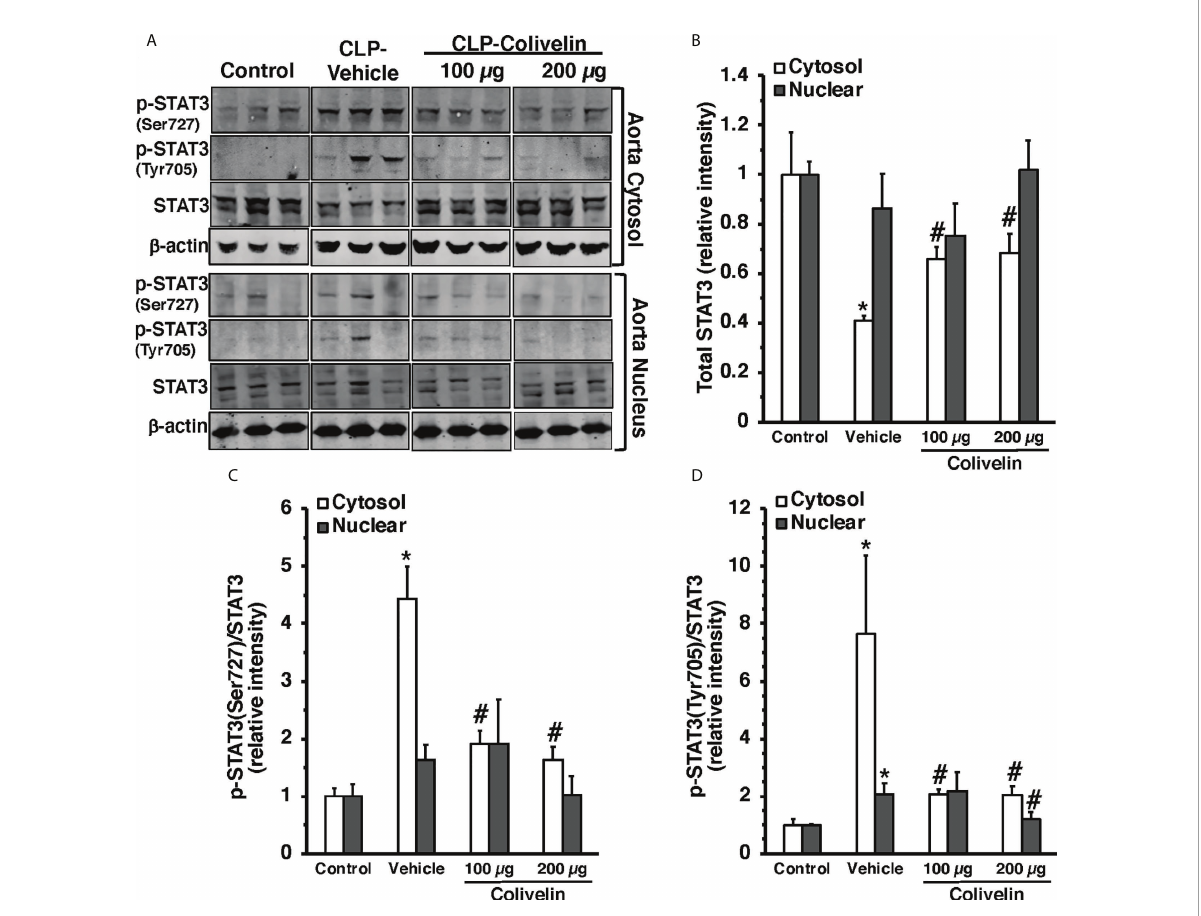
FIGURE 7 Representative Western blots of total STAT3, p-STAT3(Ser727) and p-STAT3(Tyr705) in cytosol and nuclear extracts of thoracic aorta; b -actin was used as loading control protein (A) . Image analyses of cytosol and nuclear of relative intensity of total STAT3 (B) , ratio of p-STAT3(Ser727)/ STAT3 (C) , and ratio of p-STAT3(Tyr705)/STAT3 (D) as determined by densitometry. Vehicle (200 µl distilled water) or colivelin (100 µg/kg) was administered intraperitoneally at 1 h after CLP. Each data represents the mean ± SEM of 3-4 animals for each group. *Represents P < 0.05 versus control mice; #represents P < 0.05 versus vehicle-treated